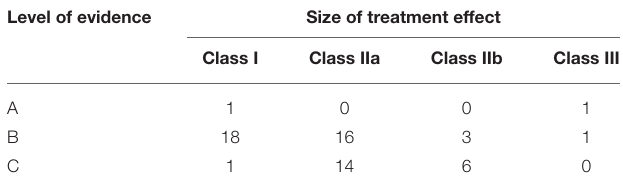
TABLE 3 | The details of 55